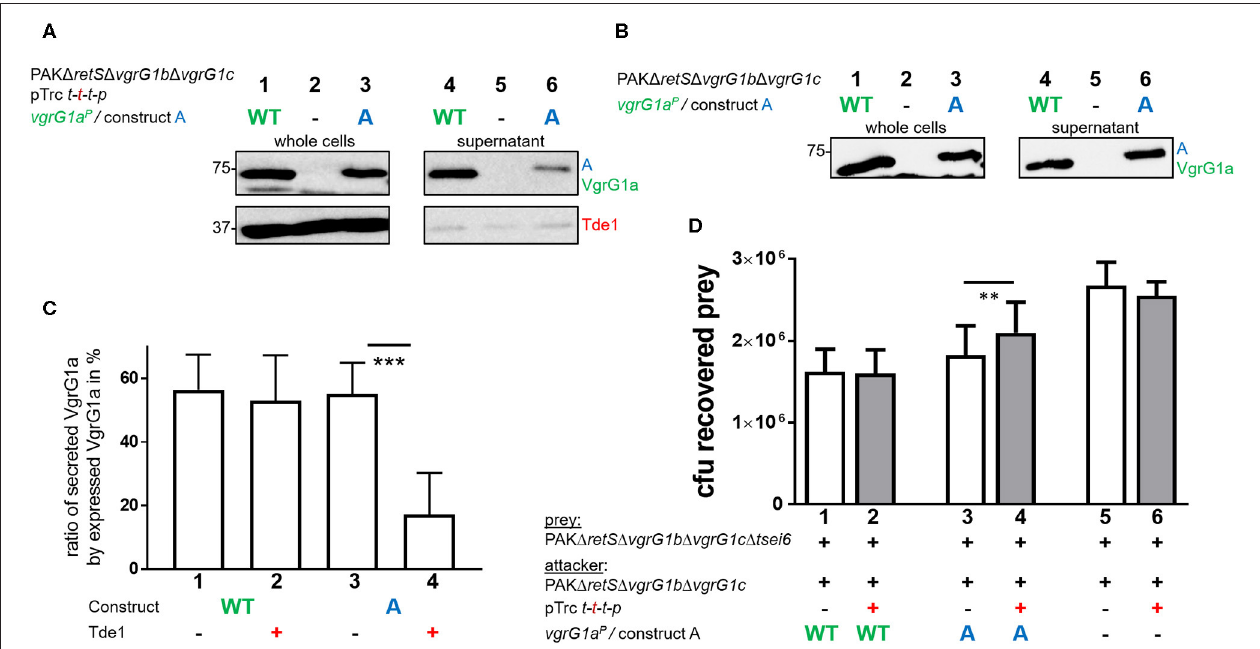
FIGURE 5 | Presence of Tde1 interferes with delivery of construct A and the VgrG1a-dependent effector Tse6. (A,B) Sections of western blots from secretion assays of PAK 1 retS 1 vgrG1b 1 vgrG1c expressing native VgrG1a P (WT) or chimera A (A) . In A, tap1-tde1-tdi1-paar is co-expressed from pTrc200, but not in (B) . Antibodies were used against VgrG1abc and Tde1 as indicated on the right. (C) Percentage of secreted VgrG1a P (WT) or construct A (A) in absence (–) or presence ( + ) of tap1-tde1-tdi1-paar . Intensity of bands corresponding to VgrG1a P was measured using ImageJ and plotted. Dunnett’s multiple comparisons test was conducted with *** p < 0.001. (D) Plot of recovered cfu of prey strain PAK 1 retS 1 vgrG1b 1 vgrG1c 1 tsei6::lacZ after contact with attacker strain that expressed VgrG1a P (WT) or construct A (A) in absence (–) or presence ( + ) of tap1-tde1-tdi1-paar ( t-t-t-p ) from pTrc200 from five independent experiments. Spots were incubated for 5h at 37 ◦ C in a 5:1 ratio. One-Way ANOVA analysis with Sidak’s multiple comparisons test was conducted between the datasets obtained from the two genetically same strain backgrounds with ** p <